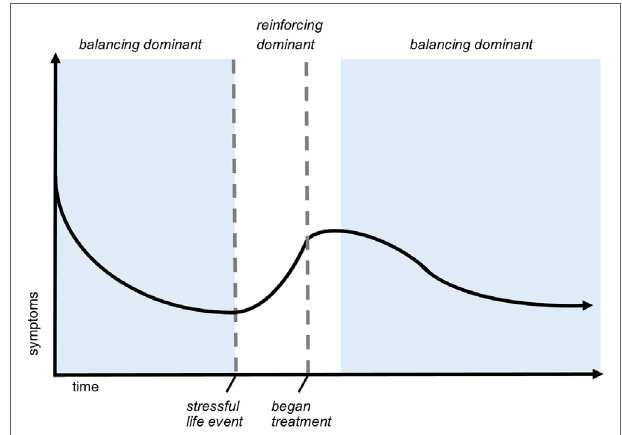
FigUre 9 | Shifting loop dominance evidenced in trajectory of symptoms over time. This hypothetical graph of symptom severity over time demonstrates a pattern of shifting dominance of interlinked feedback loops. In the scenario, the patient is injured at t = 0 and experiences a decreasing severity of symptoms. During this time (indicated by the first blue phase), balancing feedback is dominant. After a stressful life event, symptoms exponentially increase, meaning that reinforcing loops are dominant. Shortly after beginning treatment, balancing processes again dominate, indicated by the second blue phase. This sample recovery trajectory illustrates how feedback structure can cause nonlinear behavior of different types throughout